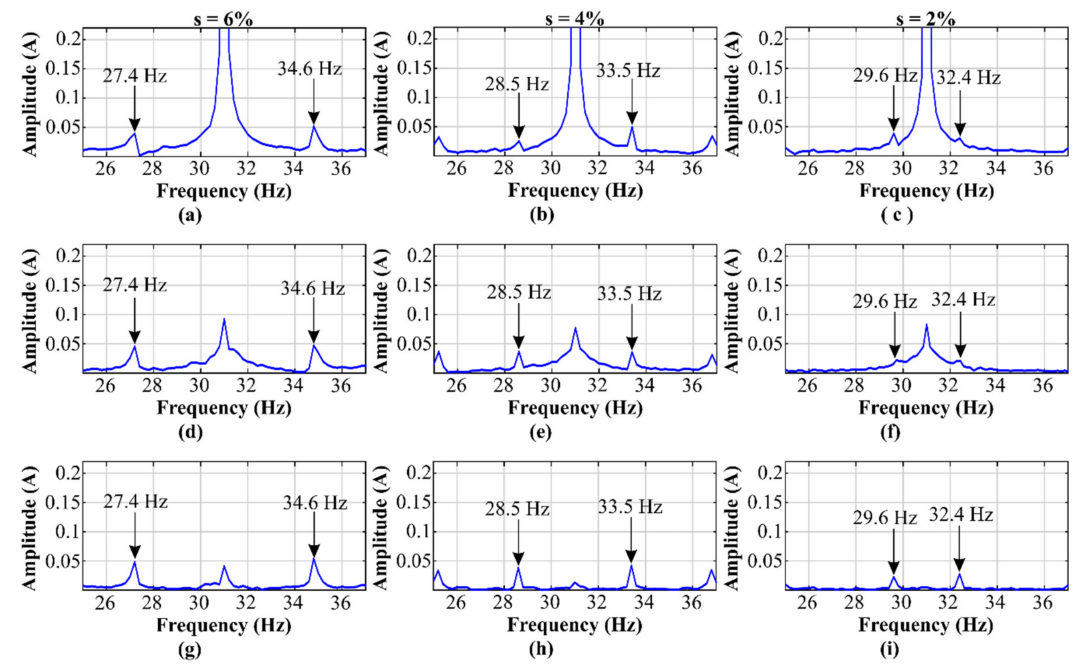
Figure 3. Spectrum for the motor current operating at 31 Hz using ( a ) Motor current signature analysis (MCSA) at high load, ( b ) MCSA at medium load, ( c ) MCSA at low load, ( d ) Notch filter (NF) and MCSA (NF-MCSA) at high load, ( e ) NF-MCSA at medium load, ( f ) NF-MCSA at low load, ( g ) Genetic algorithm (GA) and MCSA (GA-MCSA) at high load, ( h ) GA-MCSA at medium load, and ( i ) GA-MCSA at